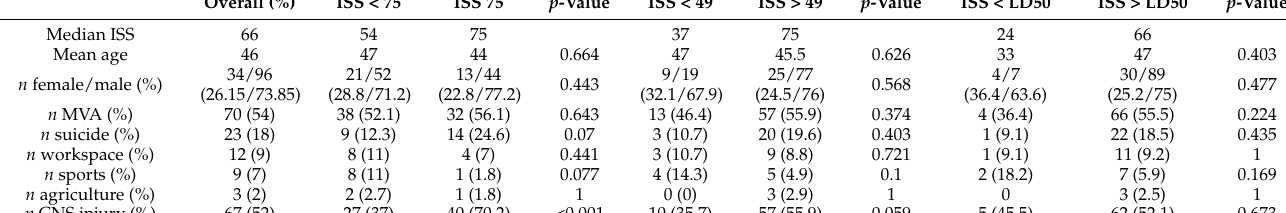
Figure 5. Relative frequencies of causes of death for ( a ) maximal (clear) vs. submaximal (patterned) trauma, ( b ) unsurvivable (ISS > 49, clear) vs. potentially survivable (ISS < 49, patterned) trauma, and ( c ) unsurvivable (ISS > LD50, Figure 4. Age versus Injury Severity Score (ISS) for trauma victims with submaximal trauma/ISS < 75 ( a ), potentially clear) vs. potentially survivable (ISS < LD50, patterned) trauma. Relative frequency of CNS injury was always higher in survivable injuries/ISS < 49 ( b ), and age versus Injury Severity Score (ISS) and LD50 derived from Bull’s probit analysis the suspected higher traumatized group but reached significance only in the comparison of maximal to submaximal ( c ). Submaximal trauma was present in 56% and potentially survivable trauma in 22% and 9%, respectively. trauma ( a ). In turn, airway compromise was more frequently observed in victims sustaining potentially survivable injury with significance only when comparing maximal to submaximal trauma ( a ). Similarly, MOF was more frequent in submaximal ( a ) and potentially survivable ( b , c ) trauma. *** p < 0.001, ** p < 0.01, ns: not significant.